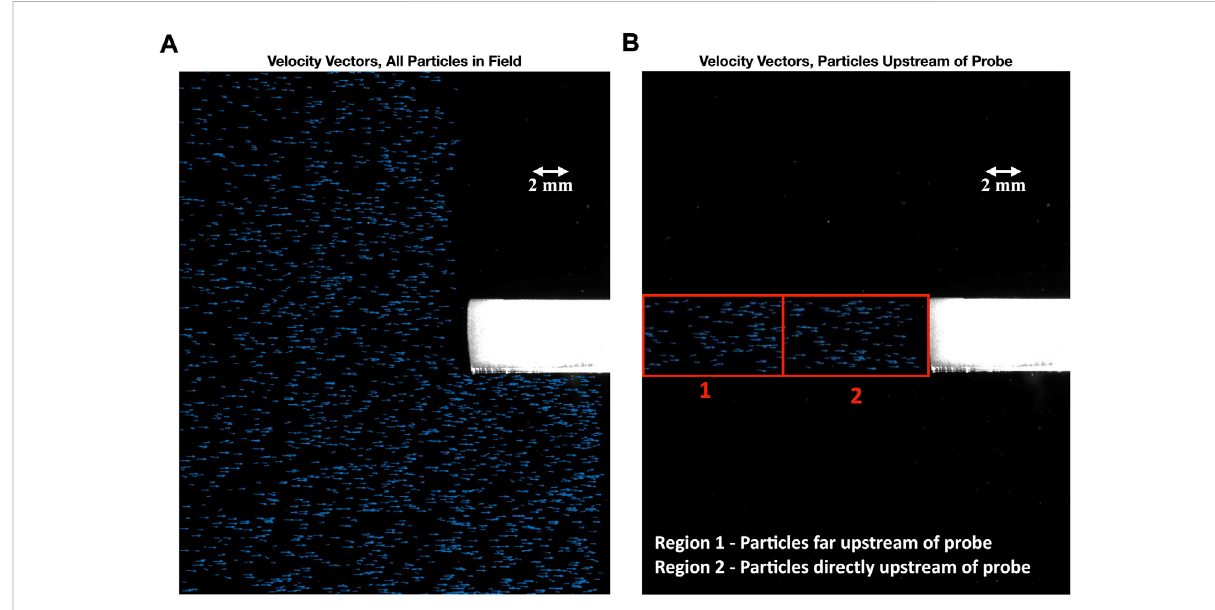
FIGURE 10 Particle velocity vectors for full fi eld (A) and for regions far upstream (1) and directly upstream (2) of sampling probe (B) .